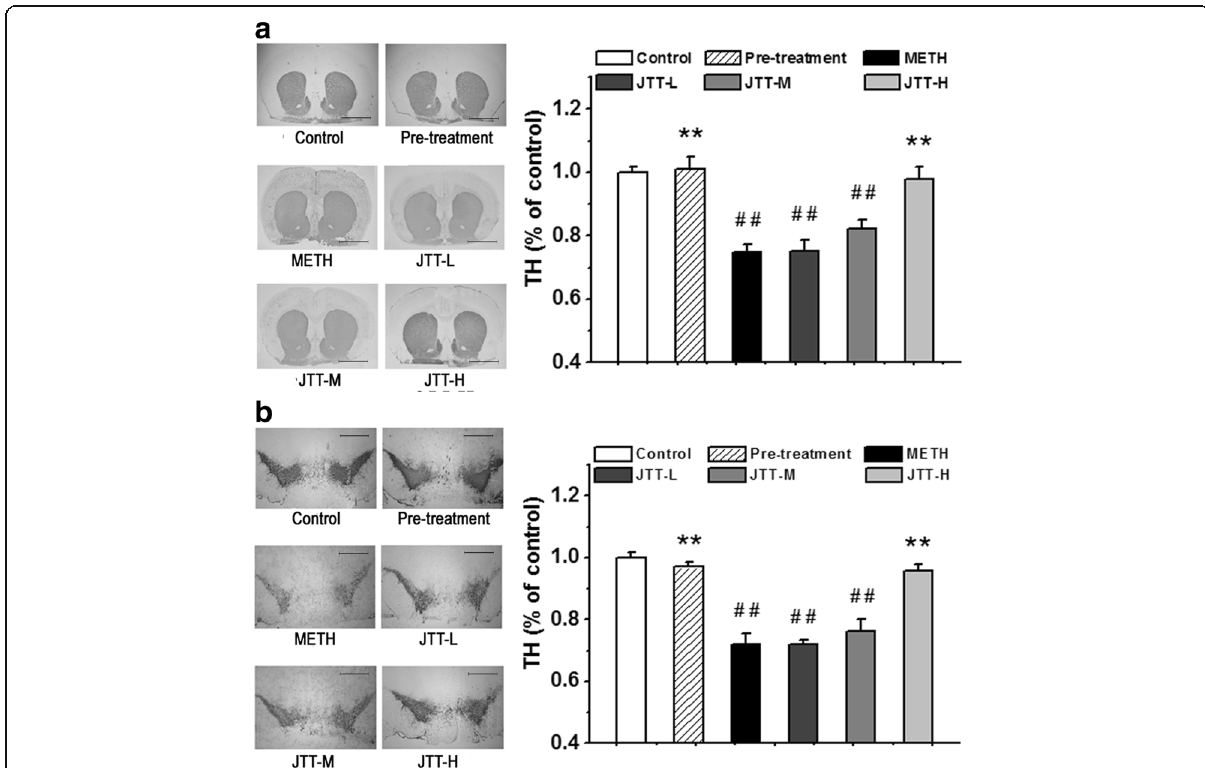
Fig. 4 Effects of Jitai (JTT) on optical densities of tyrosine hydroxylase (TH) in the striatum ( a ) (Bar = 5.00 mm) and substantia nigra (SN) ( b ) (Bar = 2.00 mm). The loss of TH-positive neurons in the striatum and SN due to methamphetamine (METH) administration were suppressed by JTT pre-treatment, or reversed by post-treatment with a high dose of JTT (JTT-H). Data are expressed as mean±SD (n=5). METH group vs. control group: # p <0.05, ## p <0.01; JTT treatment group vs METH group: * p <0.05, ** p